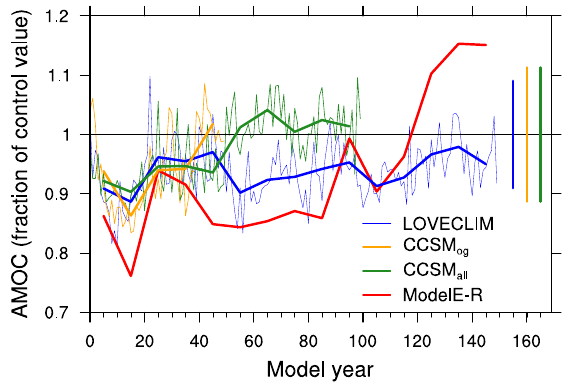
Fig. 3. Time series of AMOC intensity anomalies following the MWP, expressed as a fraction of the long-term control mean. The MWP of 2.5Sv for one year was added at Model year 1. AMOC in- tensity is defined as the maximum value of the overturning stream- function below 500m water depth (excludes shallow wind-driven overturning). Heavy lines are decadal averages. Vertical lines on the right show the 2-sigma range of interannual variability in the con- trol simulations, and are not shown for ModelE-R since only 30yr control averages are